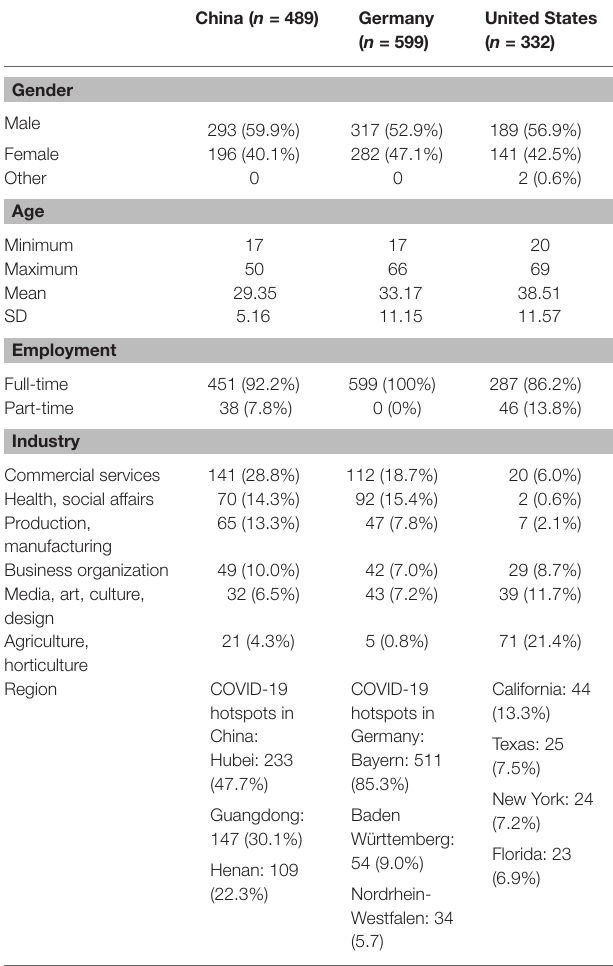
TABLE 1 | Sample demographic